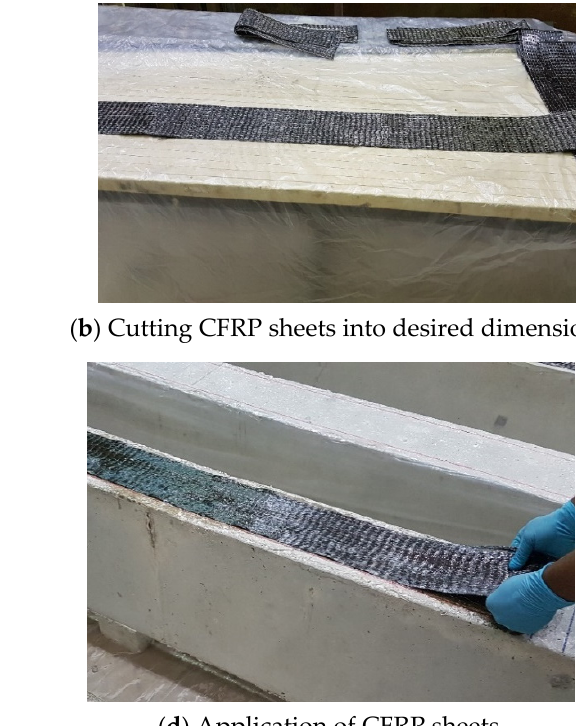
Table 3. Summary of test results.